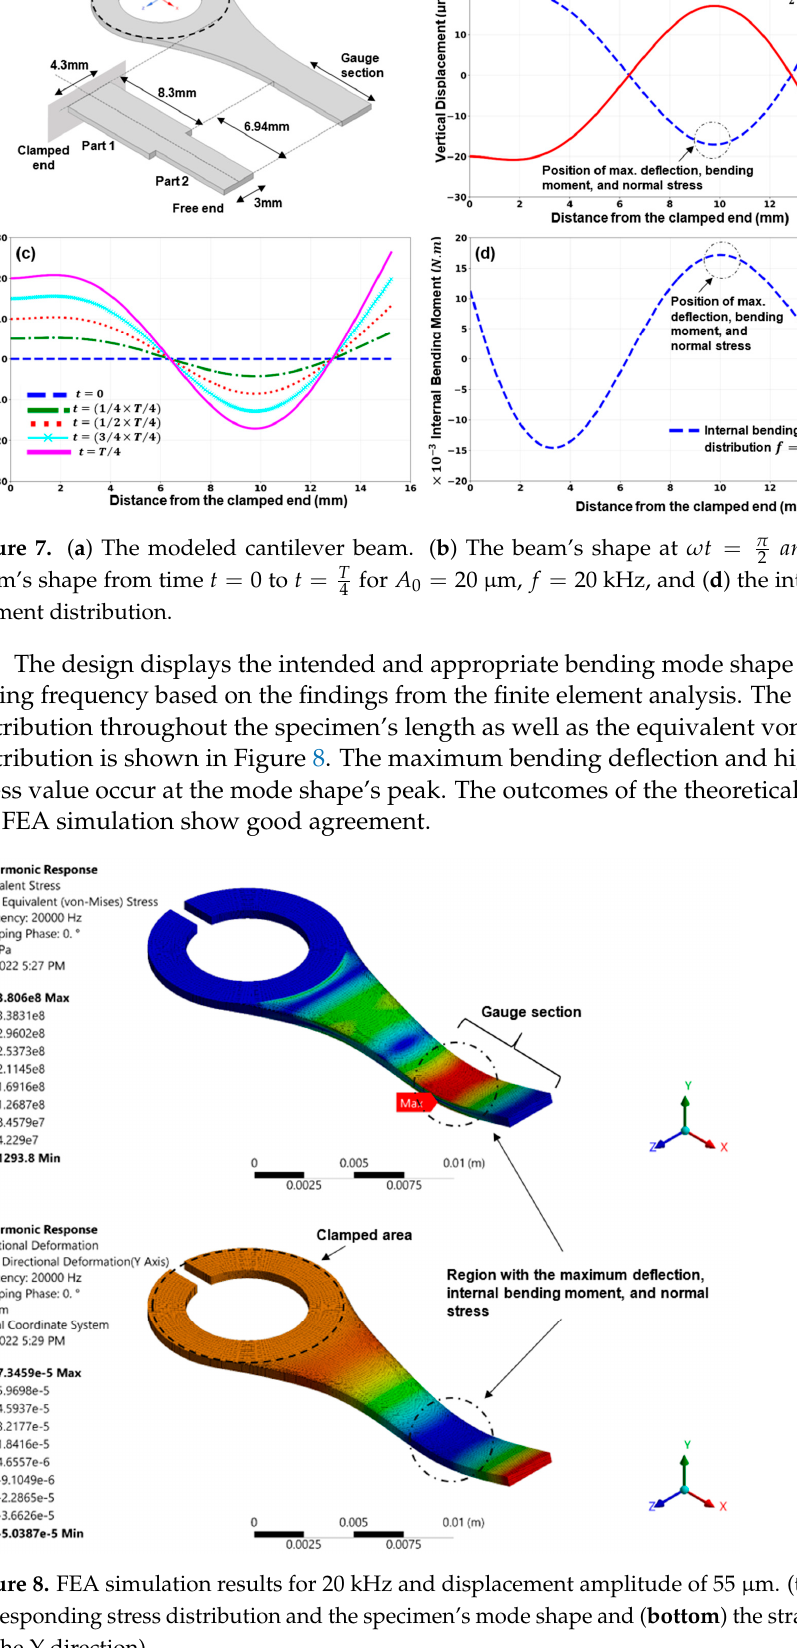
Figure 8. FEA simulation results for 20 kHz and displacement amplitude of 55 μ m. (top) Shows the corresponding stress distribution and the specimen’s mode shape and (bottom) the strain distribu- tion (in the Y direction). corresponding stress distribution and the specimen’s mode shape and ( bottom ) the strain distribution (in the Y